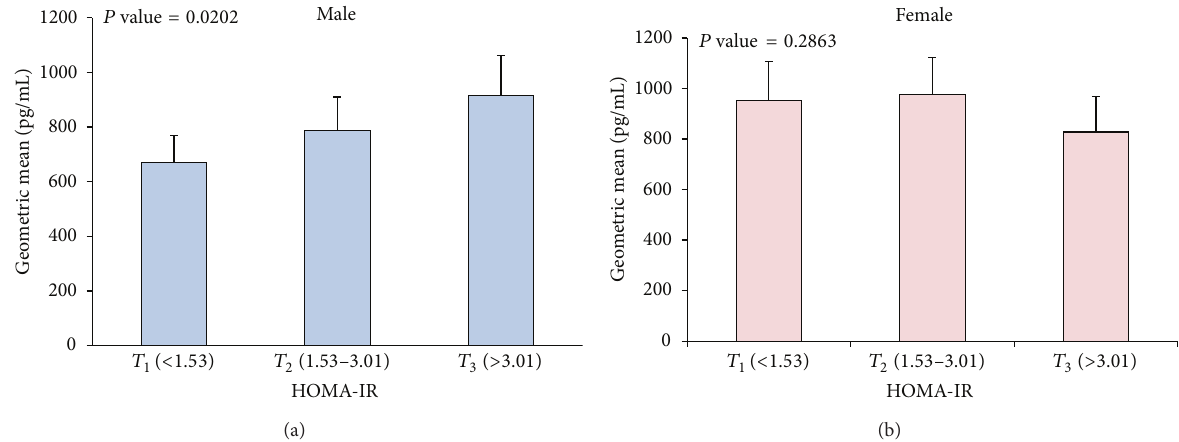
Figure 5: Age and BMI adjusted geometric means of ghrelin level and their effect on HOMA-IR. (a) Age and BMI adjusted ghrelin levels according to tertiles of HOMA-IR ( 𝑇 1 < 1.53, 1.53 ≤ 𝑇 2 ≤ 3.01, and 𝑇 3 > 3.01) showing association between increasing insulin resistance and increasing ghrelin level in males ( 𝑃 -trend = 0.0202). (b) Age and BMI adjusted ghrelin levels according to tertiles of waist to hip ratios showing no significant change in ghrelin level in subjects with increasing level of insulin resistance as measured by HOMA-IR in